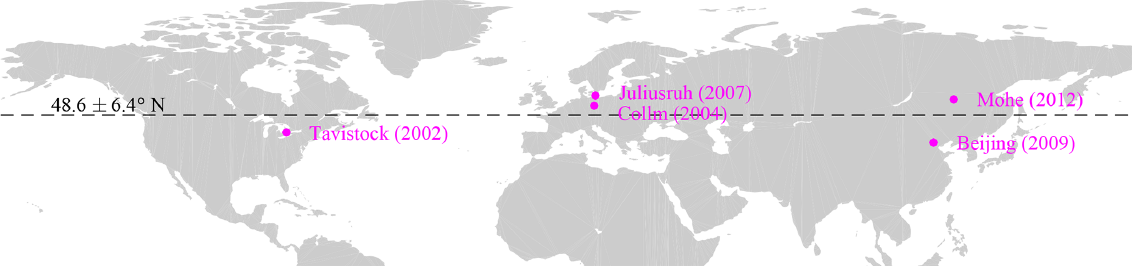
Figure 2. Distribution of five SMRs used in the current study. The numbers following the location names present the earliest available years of the corresponding